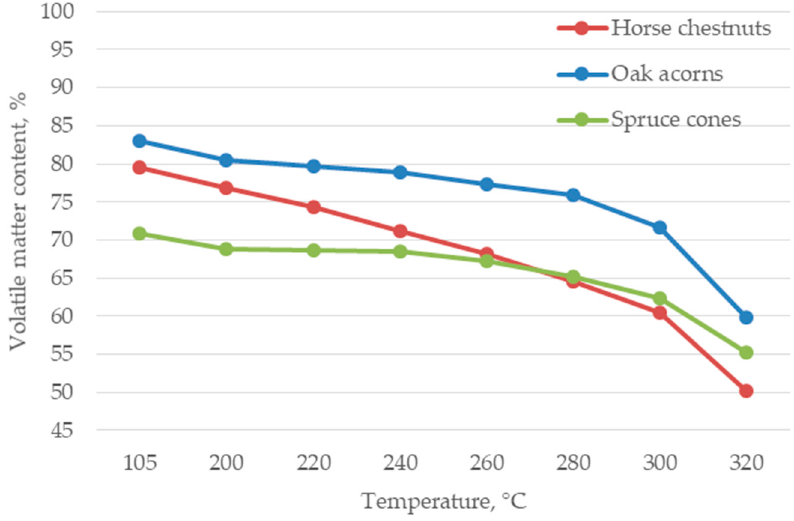
Figure 7. Volatile matter content in the torrefied horse chestnuts, oak acorns, and spruce cones.